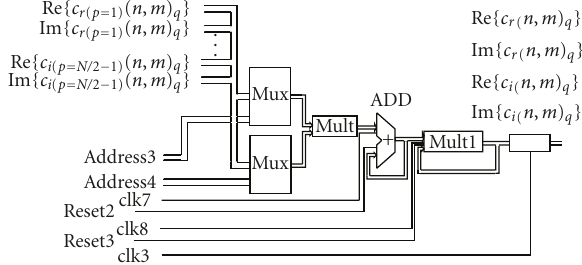
Figure 12: Serial Architecture for realization of concentration and c i ( n , m ) (Block23). functions c r ( n , m ) q q